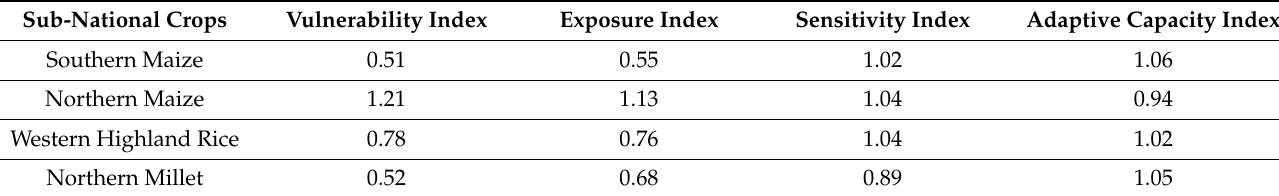
Table 2. Sub-national vulnerability indices at four sub-national sites.